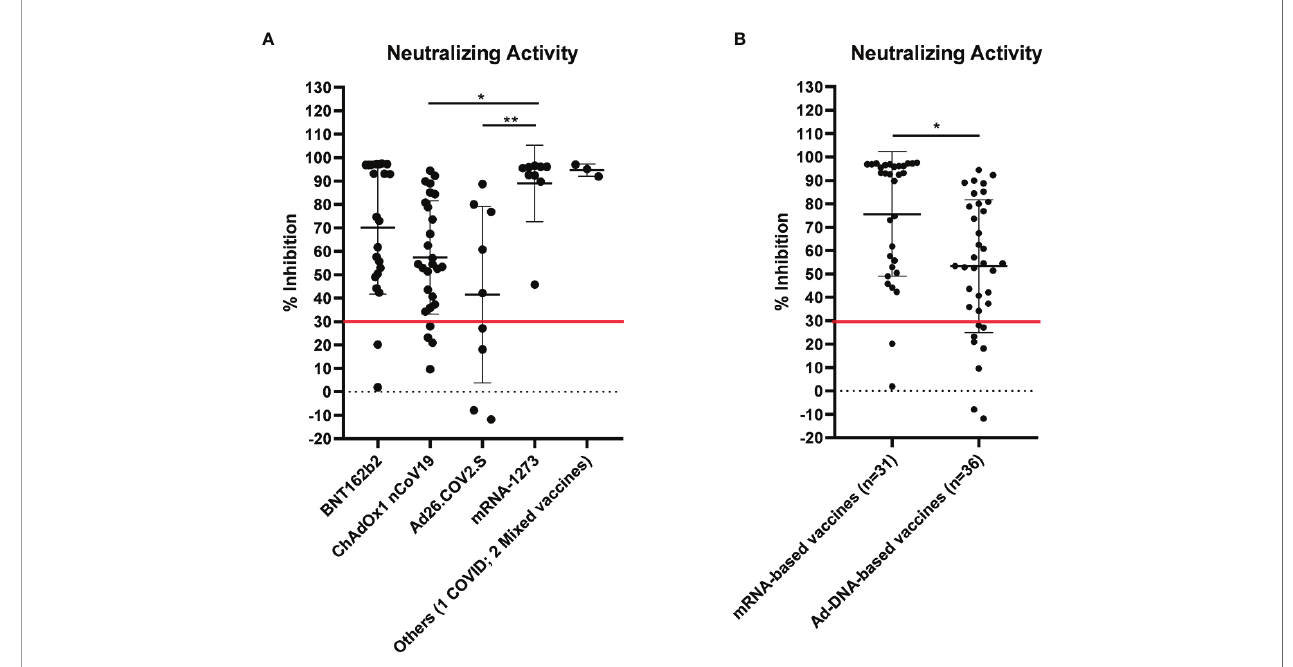
FIGURE 3 | Neutralizing activity evaluated by cPass ™ ELISA-based SARS-CoV-2 Neutralization Antibody Detection Kit in 70 sera from differently vaccinated individuals. Serum samples were considered positive when ≥ 30% inhibition was measured, as shown by the red line in the graph. (A) Percentage inhibition of receptor-binding domain – angiotensin-converting enzyme 2 (RBD-ACE2) binding within different vaccination groups (see also Table 3 ). Statistical signi fi cance was assessed by ANOVA following Tukey ’ s multiple comparisons test, ** p < 0.005, * p < 0.05. (B) Comparison of neutralizing activity in sera from individuals who received adenoviral DNA-based vaccines and mRNA-based vaccines. Statistical signi fi cance was assessed by unpaired t-test, * p = 0.0016.